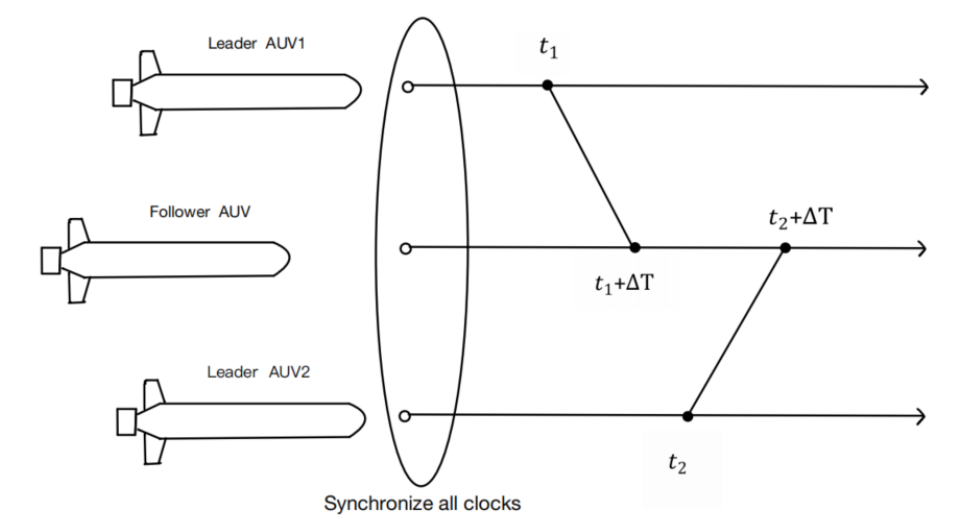
Figure 1. Architecture of multiple AUVs cooperative localization based on two leaders